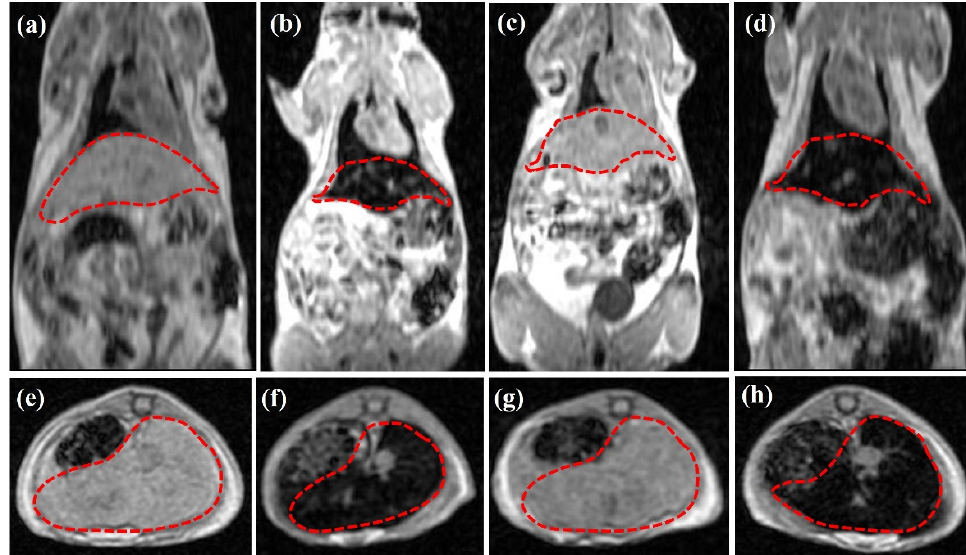
Figure 3. Representative T 1 -weighted ( a – d ) coronal and ( e – f ) axial MRI data of n = 4 normal Swiss mice: ( a , e ) without any CA/DMCA; ( b , f ) with non-radiolabeled DPD-Fe 3 O 4 CA at a concentration of C CA = 0.1 mg/mL; ( c , g ) with [ 99m Tc]Tc-DPD-Fe 3 O 4 DMCA at C DMCA = 0.01 mg/mL; ( d , h ) with [ 99m Tc]Tc-DPD-Fe 3 O 4 DMCA at C DMCA = 0.1 mg/mL. All MRI images were acquired 6 h p.i. The dotted red lines indicate the area of interest (liver and spleen).